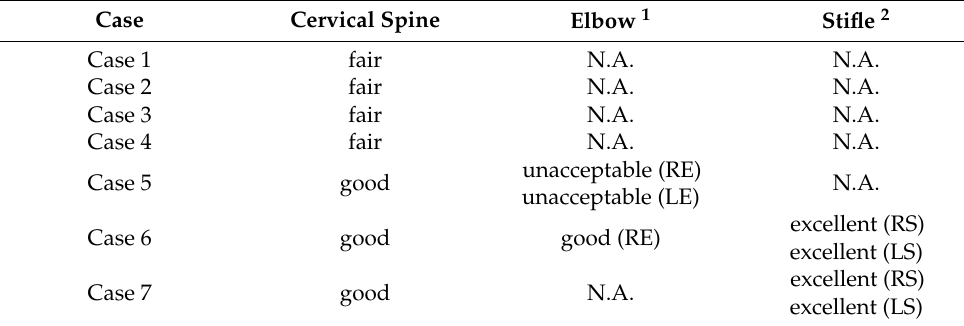
Table 2. Overall kMRI scores (pre- and post-surgical